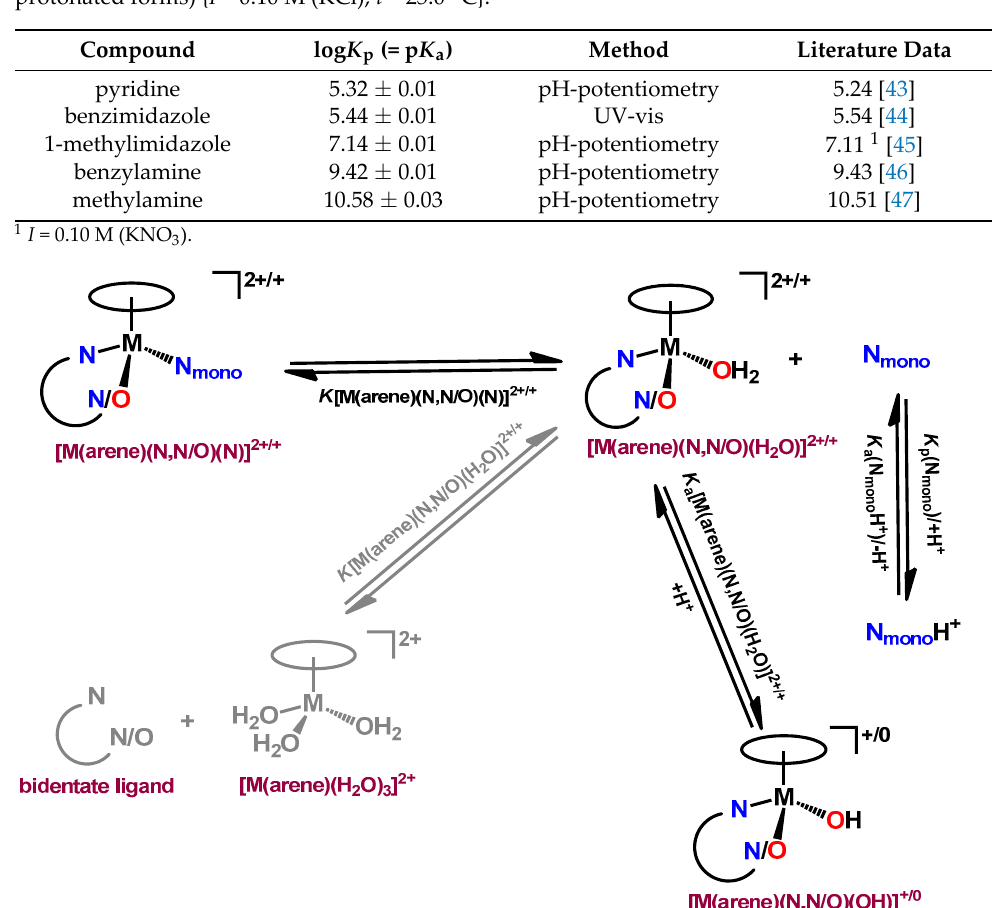
Table 1. Protonation constants of the monodentate ligands (proton dissociation constants of the